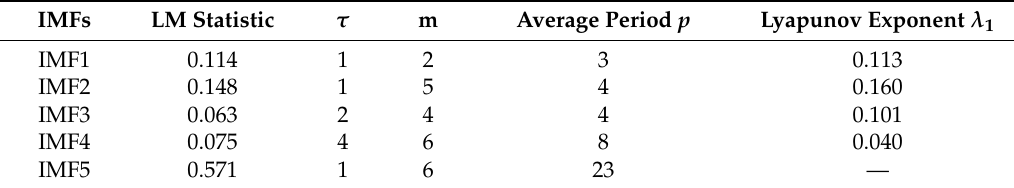
τ I of IMF1, IMF2, IMF3, IMF4, and IMF5 for